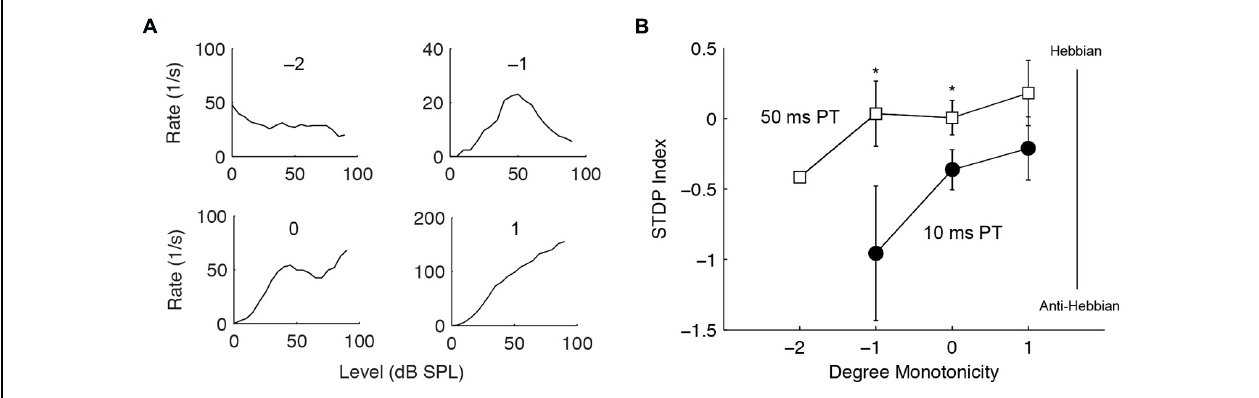
FIGURE 7 | Stronger inhibition predicts Hebbian–anti-Hebbian timing rule divergence. (A) Four representative units’ rate-level responses showing different degrees of monotonicity. Monotonicity of − 2 indicates highly non-monotonic responses (strong inhibition) while that of 1 indicates monotonic